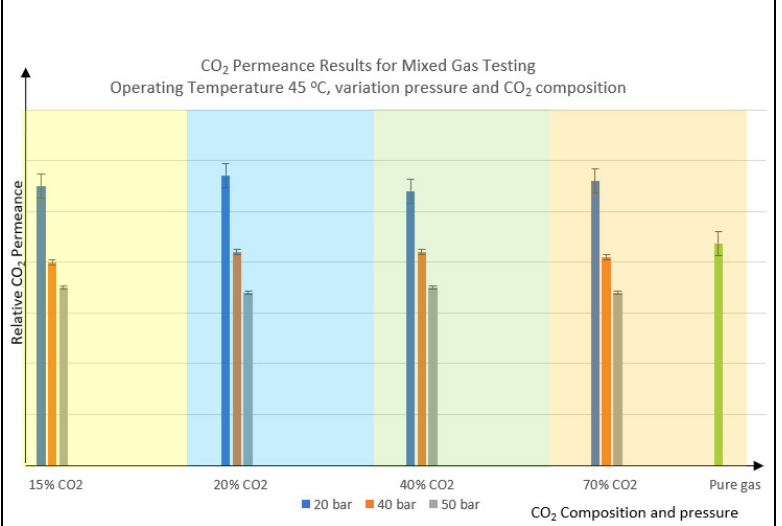
Figure 3. CO 2 permeance result for mixed gas testing vs. variation of CO 2 composition and feed pressure. Note: Pure gas testing condition is 25 °C with 3 to 7 barg applied pressure.